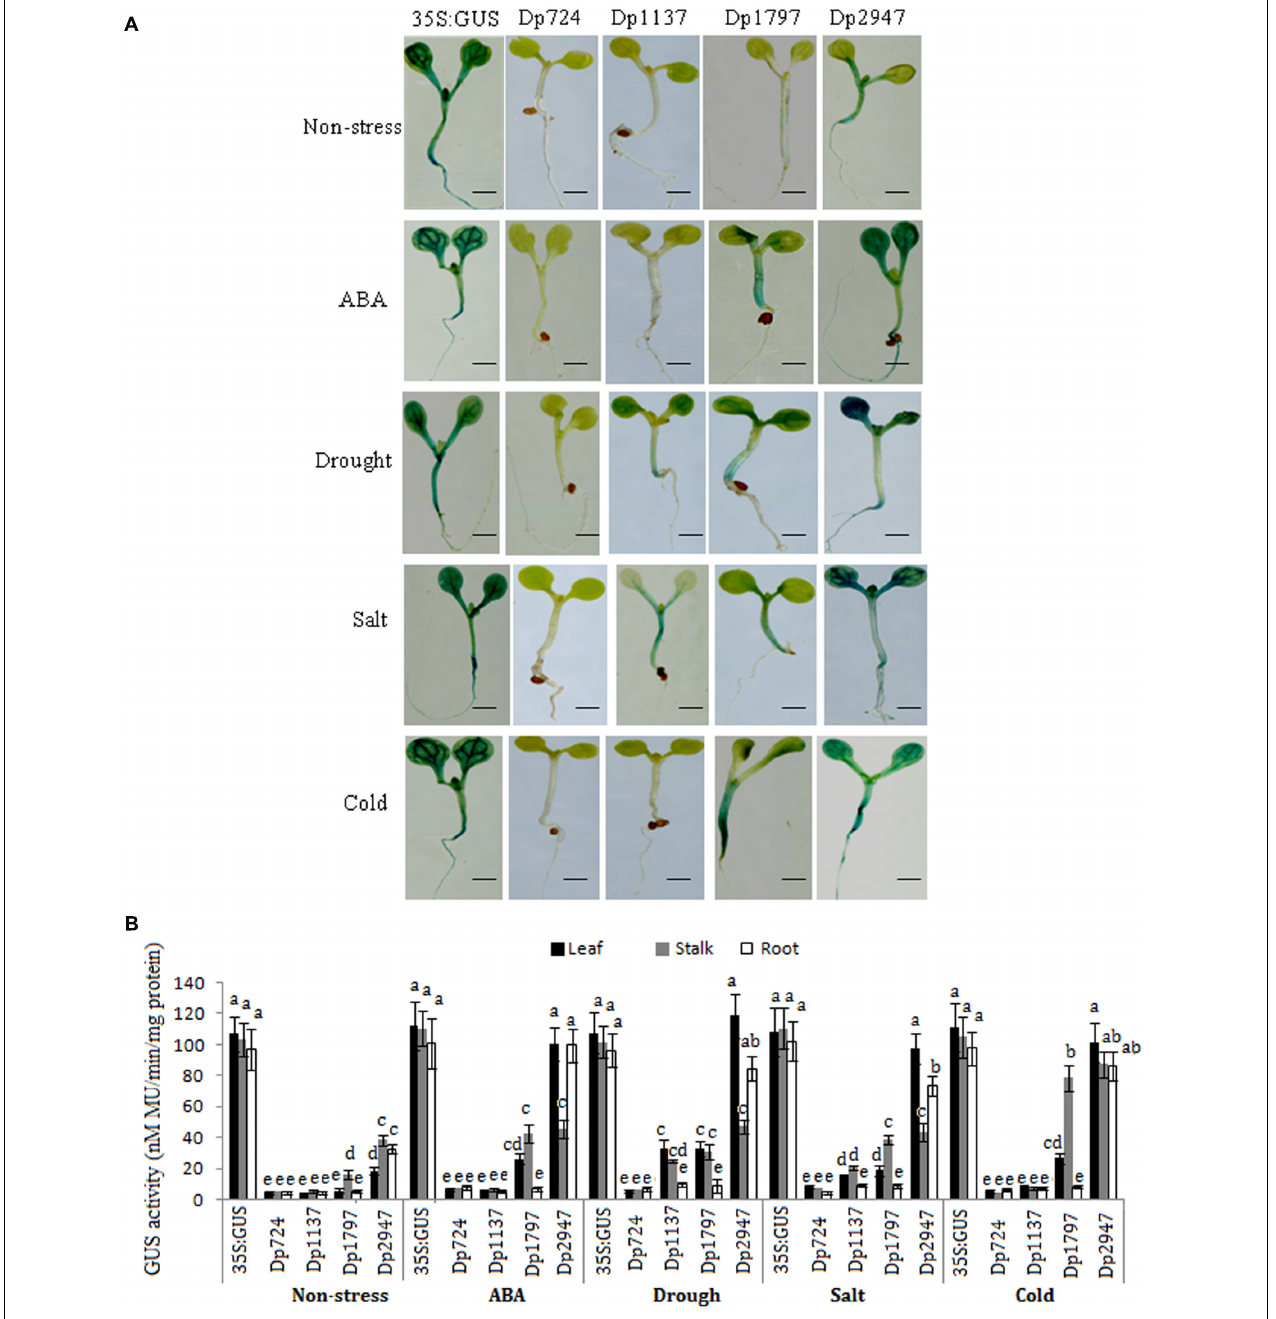
FIGURE 4 | Effects of various abiotic stresses on the GUS activity under the control of different TaSnRK2.8 promoter deletion segments in the transgenic Arabidopsis seedlings. (A) GUS staining of transgenic Arabidopsis seedlings containing promoter deletion constructs under normal and stress conditions. (B) GUS activity under the control of different TaSnRK2.8 promoter deletion segments. The 7-day-old seedlings were planted on the MS medium containing 150 mM NaCl (salt), 150 mM mannitol (drought), or 50 µ M ABA. Cold, cultured in a cold growth chamber (4 ◦ C). The plants used for the analysis were two independent lines carrying the promoter deletion constructs. GUS activity was expressed as nM MU/min/mg protein. Values are the mean ± SE ( n = 20). a − e Values followed by the different letter are significantly different ( P < 0.05). Dp724, Dp1137, Dp1797, and Dp2947 indicate the TaSnRK2.8 promoter regions from –408 to +316, –821 to +316, –1481 to +316, and –2631 to +316, respectively. Bar, 2 mm.